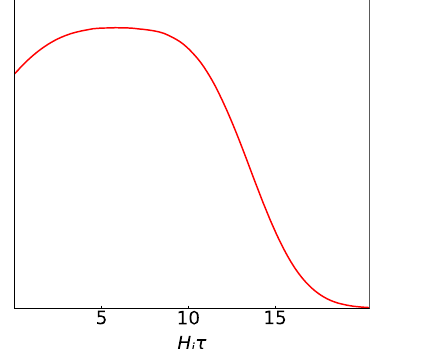
Fig. 14 Posterior distribution of the time delay parameter τ using the growth rate data set alone. The median estimate is H i τ = 7 . 11 + 4 . 95 − τ = 0 . 1232 + 0 . 0874 − 0 . 0806 Gyr